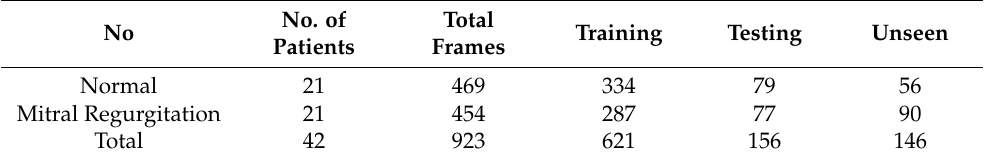
Table 2. Dataset for training, testing, and